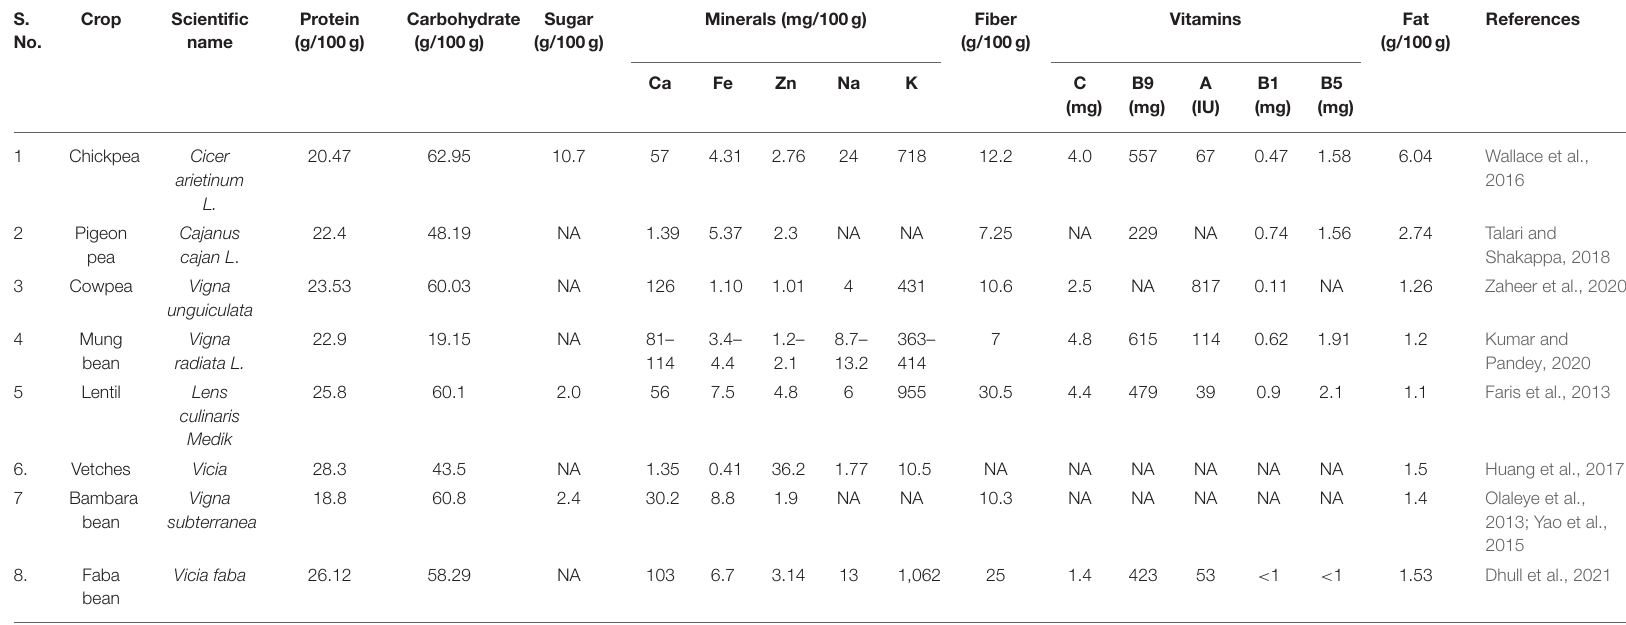
TABLE 2 | Protein and carbohydrate content in common